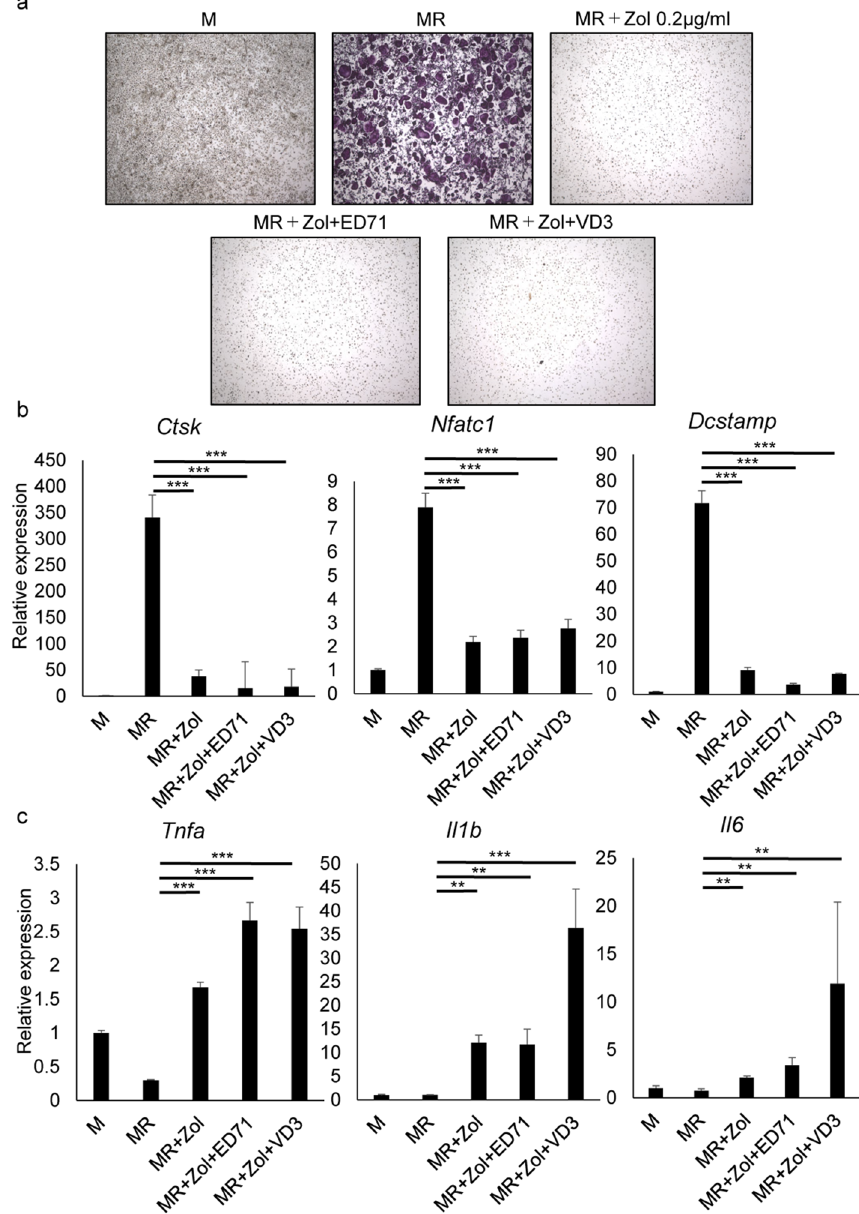
Figure 2. ED71 or VD3 does not inhibit inflammatory cytokine expression in macrophages or osteoclasts. Osteoclast progenitors were isolated from wild-type mice and cultured in the presence or absence of M-CSF (M) or M-CSF (M) and RANKL (R) with or without 0.2 µg/ml zoledronate (Zol) with or without either ED71(10 -6 M) or VD3 (10 -6 M). Osteoclast formation was evaluated by TRAP staining ( a ) or quantitative RT-PCR analysis of expression of indicated osteoclast markers. Tnfa , Il1b , and Il6 expression was also analyzed by quantitative RT-PCR ( b , c ). Data represent mean Ctsk, Dcstamp, Nfatc1, Tnfa, Il6 or Il1b expression relative to Actb ± SD (each with n = 3, **P < 0.01; ***P < 0.001 by ANOVA). Representative data of at least two independent experiments are